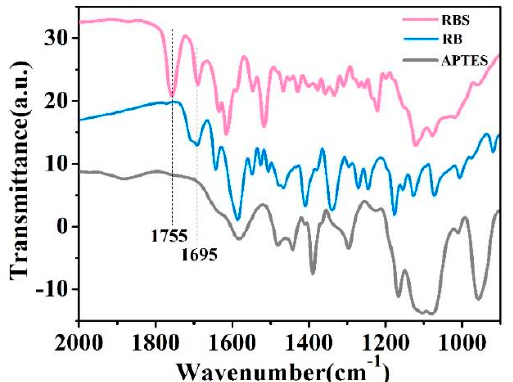
Figure 1. Figure 1. FTIR spectra of RBS (RB-APTES), RB (rhodamine B) and APTES (aminopropyltriethoxysilane). Figure 1.